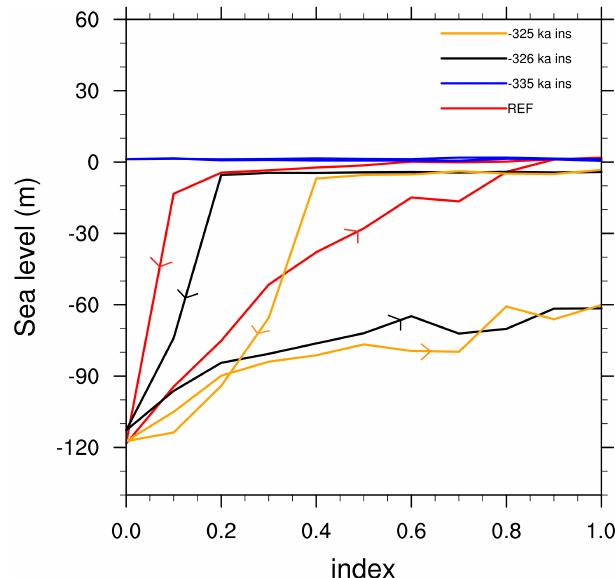
Figure 13. Modelled global sea level in hysteresis tests, where CO 2 is decreased in steps of 10ppm per 30kyr from 280 to 180ppm and then increased in the reverse manner. Insolation is kept at constant levels of 335 (high NH summer insolation, blue line), 326 (interme- diate, black line) and 325 (low, orange line) kyr ago. In the reference case (REF, red line), it is first decreased in steps of 1kyr from the high to the low extreme, and then increased back to the initial level, in phase with CO 2 . An index is assigned to the input values, lin- early ranging from favourable (180ppm CO 2 (and low NH summer insolation for REF); index 0) to unfavourable (280ppm CO 2 (and high NH summer insolation for REF); index 1) for NH